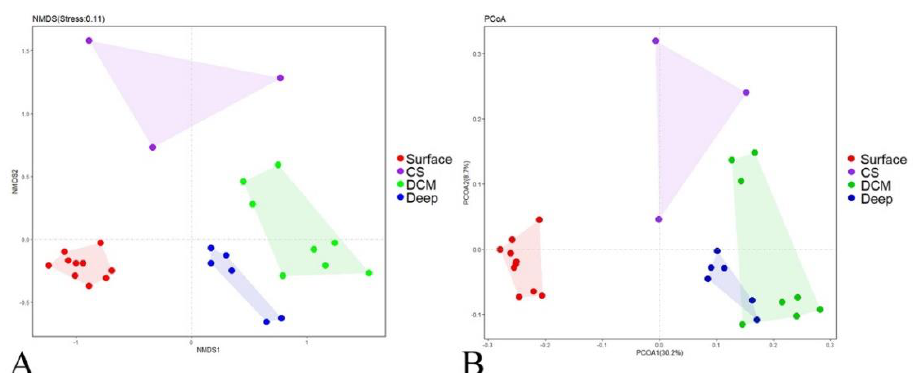
Figure 2. Plots of the nonmetric multidimensional scaling (nMDS) ( A ) ordination and principal coordinate analysis (PCoA); ( B ) based on Bray–Curtis dissimilarities of the protistan communities. Surface, surface waters; CS, coastal subsurface waters; DCM, deep chlorophyll maxima depth; Deep, deep